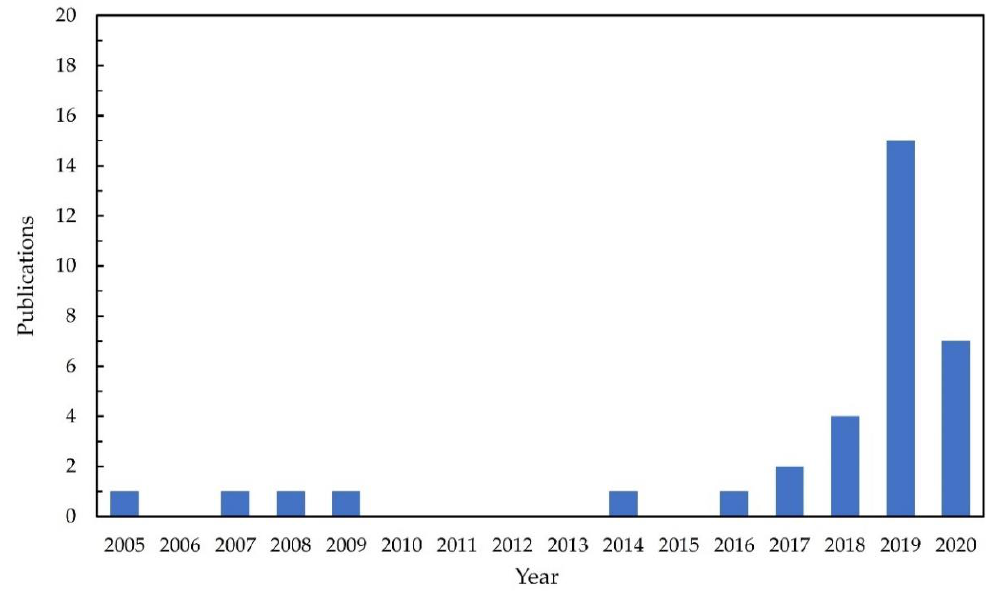
Figure 9. The number of publications that apply the deep learning models to predict solar irradiance and photovoltaic (PV) power from 2005 to and photovoltaic (PV) power from 2005 to 2020.